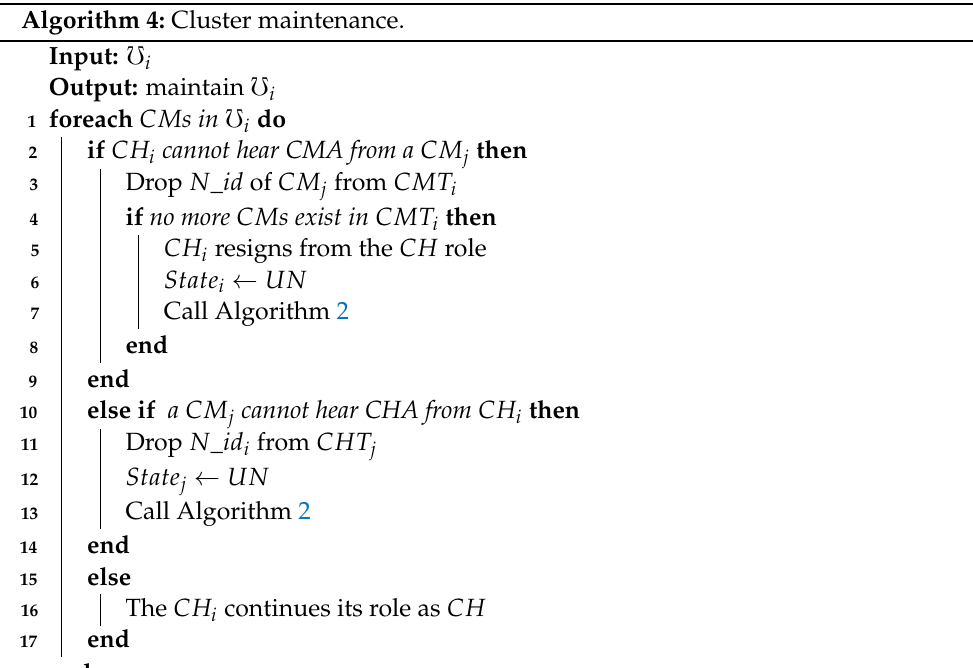
Algorithm 4: Cluster